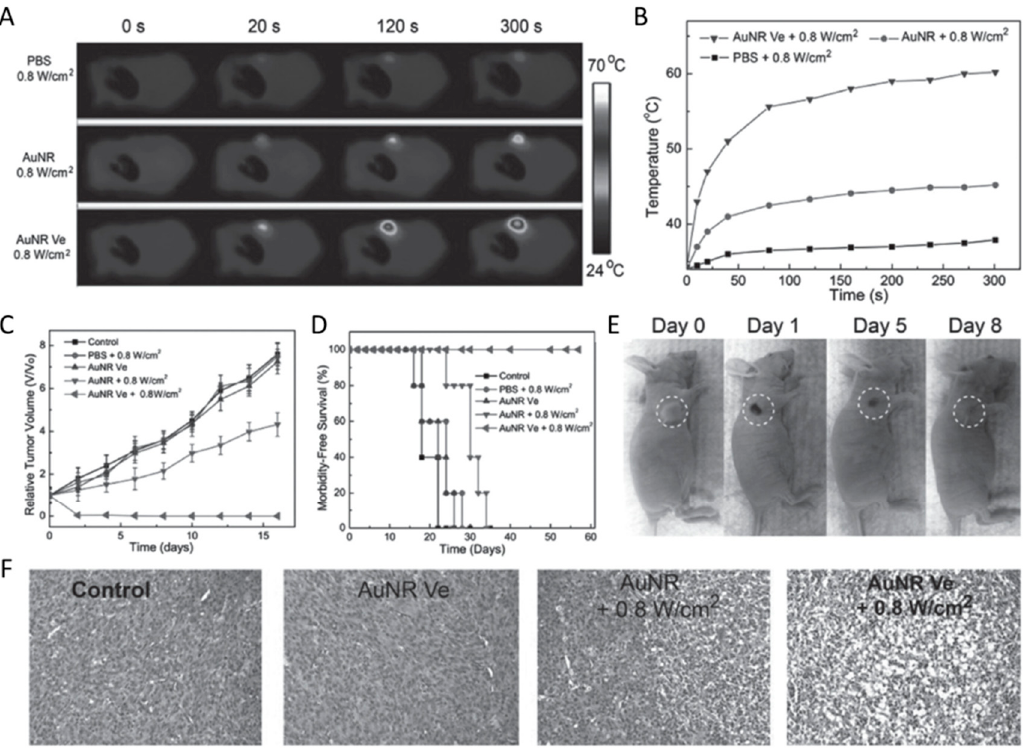
Figure 11. In vivo photothermal ablation of tumor after intravenous injection of Au nanorod vesicles followed by laser irradiation. ( A ) Infrared thermographic maps and ( B ) temperature changes of the tumor region treated with small AuNRs and AuNR Ve and irradiated with a 808 nm laser at different power densities; ( C ) tumor growth curves and ( D ) survival curves of tumor-bearing mice treated with phosphate-buffered saline (PBS), small AuNRs and AuNR Ve and laser irradiation; ( E ) photographs of the tumor-bearing mice at days 0, 1, 5, and 8 d after being treated with the AuNR Ve; and ( F ) hematoxylin and eosin (H&E) staining of the tumor tissue after different treatments [31].